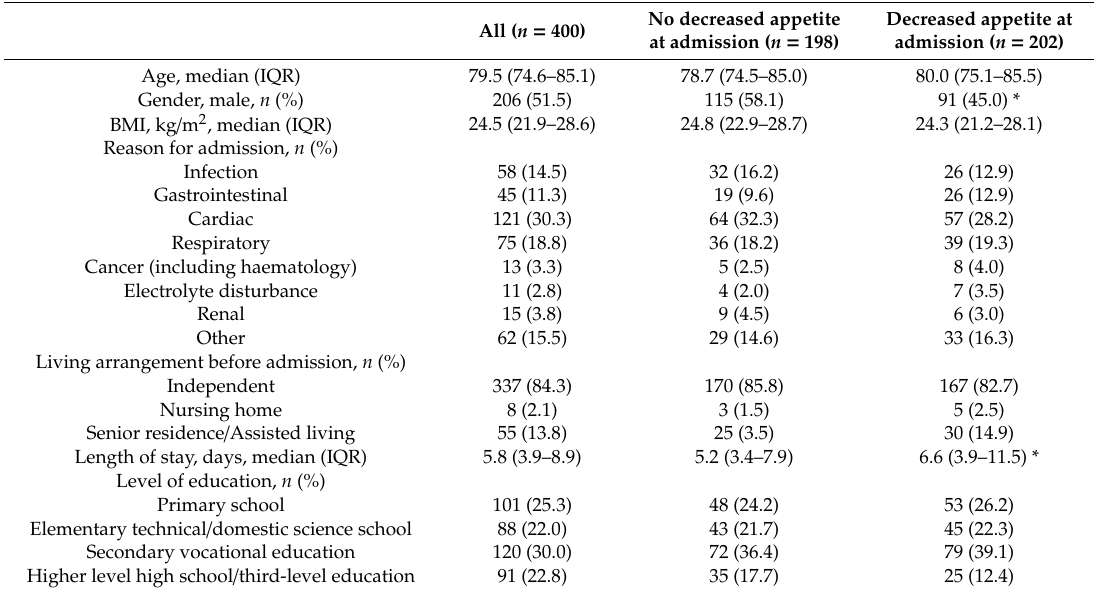
Table 1. Baseline characteristics of study